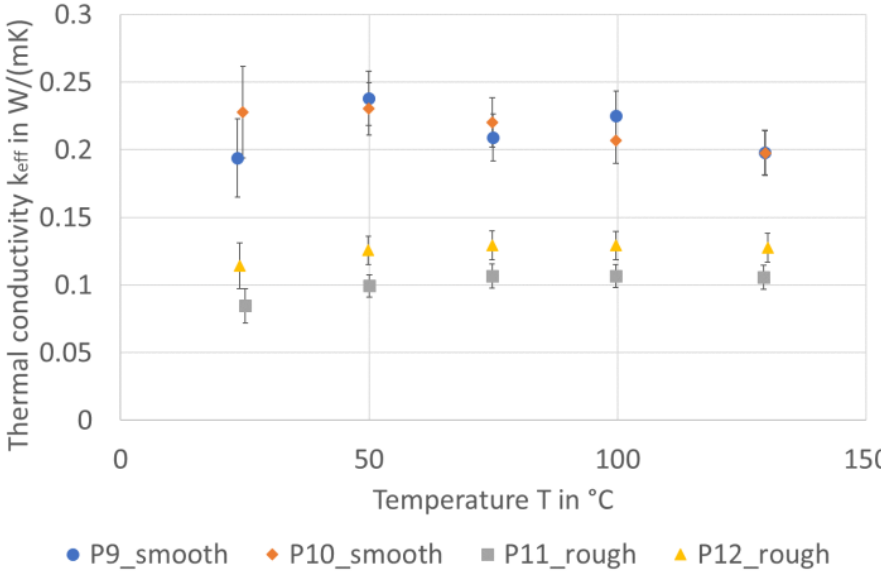
Figure 7. Thermal conductivity of TIM 2 as a function of temperature. To evaluate the performance of individual TIMs with different roughness values of the joining surfaces, the respective layer thicknesses must be compared in addition to the effective thermal conductivity (see Equation (6)). For this purpose, the thermal resistances of both corresponding samples with similar roughness are averaged in Figure 8. For all investigated TIMs, the thermal resistance increased by a factor of up to two if the surface was rough. This effect was dominant, compared to the variation of the TIMs, and showed that smooth joining surfaces are essential to reduce the thermal resistance, which can be well explained by a better wetting of the roughness